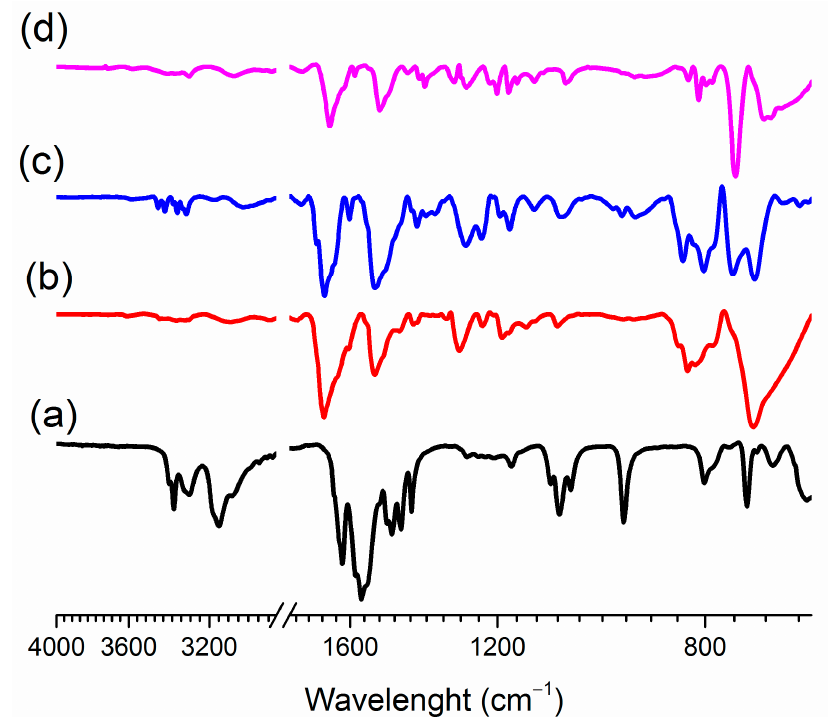
Figure 8. IR spectra of ( a ) metformin hydrochloride (HMfCl), ( b ) H 2 Mf(HpOXA) 2 ∙ 4W, ( c ) H 2 Mf(HpOXA) 2 and ( d ) H 2 Mf(HpOXA) 2 ∙ 4W after rehydration from H 2 Mf(HpOXA) 2 . and ( d ) H 2 Mf(HpOXA) 2 · 4W after rehydration from H 2 Mf(HpOXA) 2